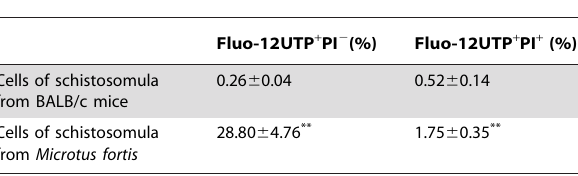
Table 5. Apoptosis and necrosis in cells of schistosomula taken from the two host species determined by Fluo-12UT/PI analysis (Mean 6 SD; N=